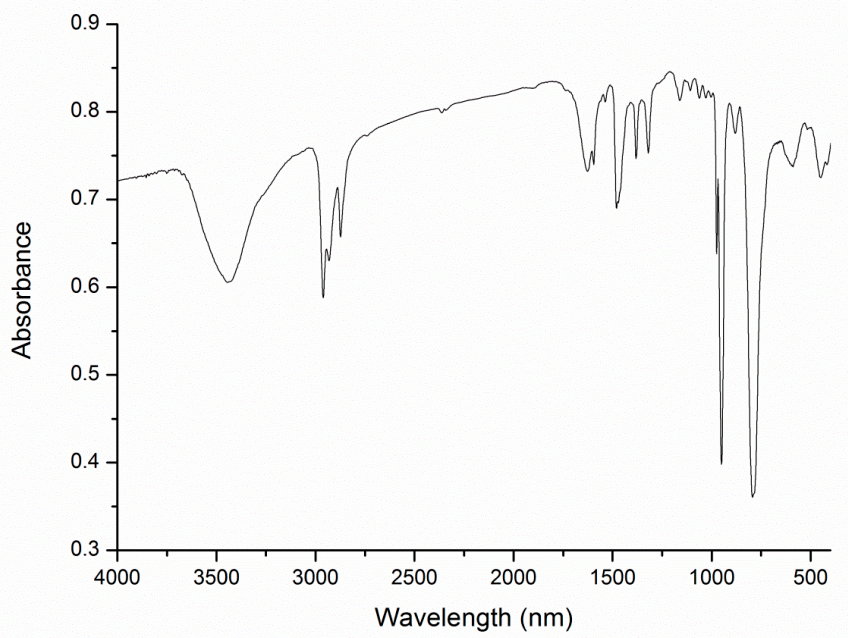
Figure A4. IR spectrum of ( 1-L4 ).